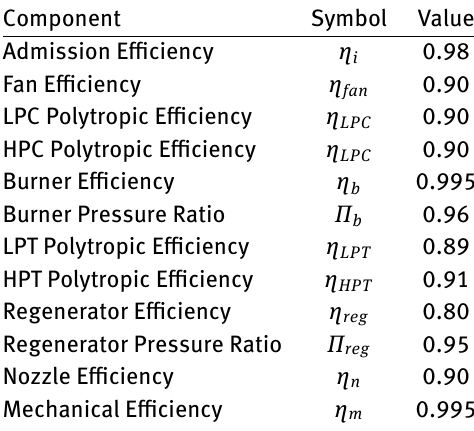
Table 2: Assumed Component Eflciencies [12]